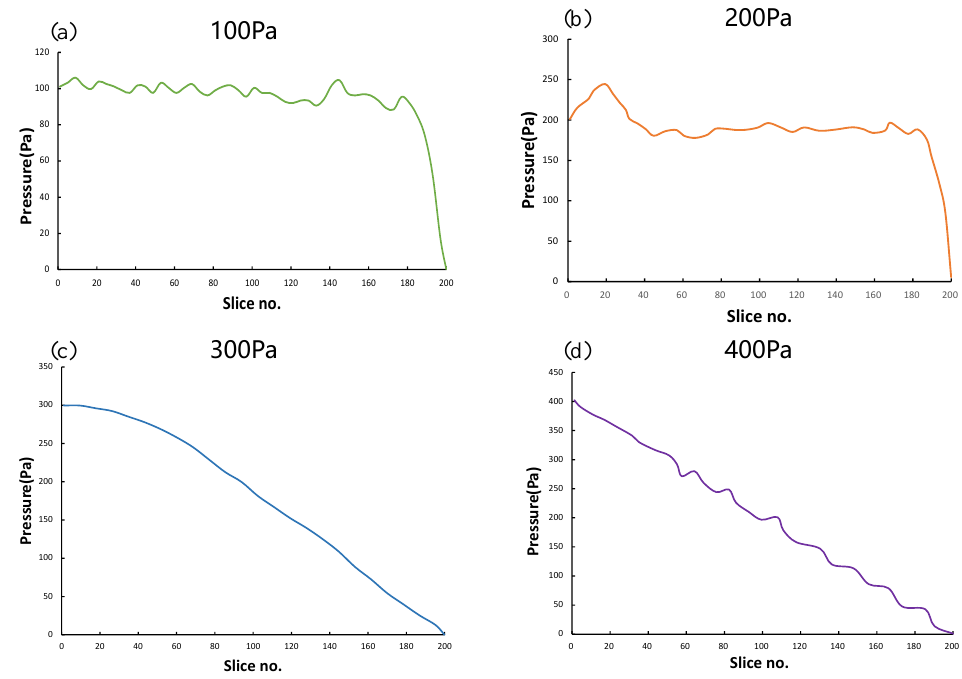
Slice no. Figure 13. Pressure profiles of the tighter REV versus CT slice when steady state is reached as P diff is equal to 100 Pa ( a ), 200 Pa ( b ), 300 Pa ( c ), 400 Pa ( d ) with the same initial conditions as Figure 12.